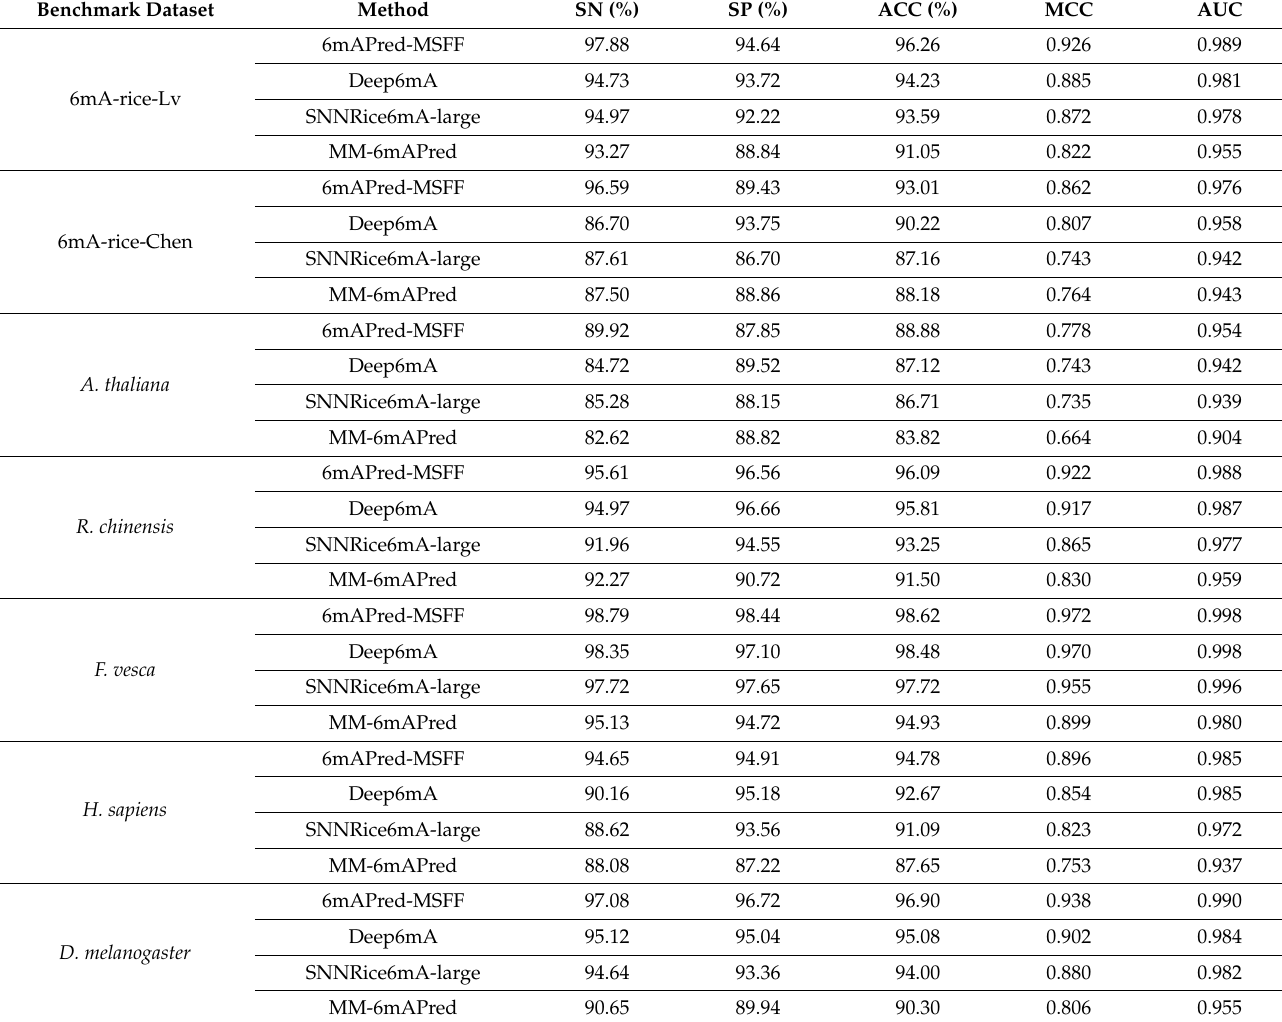
ated on the seven benchmark datasets by using 5-fold cross validation. Table 2 lists the performances of the proposed method, namely 6mAPred-MSFF, and four existing predictors on the seven datasets. For the 6mA-rice-Lv dataset, when compared to the second-best method Deep6mA, our proposed method achieves an SN of 97.88%, an SP of 96.64%, an ACC of 96.26%, and an MCC of 0.926, yielding a relative improvement over Deep6mA of 3.15%, 0.92%, 2.03%, and 4.63%, respectively. Compared with the machine learning method MM-6mAPred, our proposed method improves the performance of SN, SP, ACC, and MCC by 4.61%, 5.8%, 5.12%, and 12.65%, respectively. For the 6mA-rice-Chen dataset, compared with the runner-up predictor Deep6mA, with the only exception that the value of SP is better than ours, our proposed method improves the performance of SN, ACC, and MCC by 9.89%, 2.79%, and 6.81%, respectively. For the A. thaliana and R. chinensis datasets, with the exception that the predictor Deep6mA achieves the best value of SP, and our proposed method improves the performance of SN, ACC, and MCC by 0.28–5.2%. Moreover, we can see that the performance of 6mAPred-MSFF is also better than all other methods on the F. vesca , H. sapiens , and D. melanogaster datasets. Table 2. Performance comparison of the proposed method and 6mA predictors based on seven datasets. Benchmark